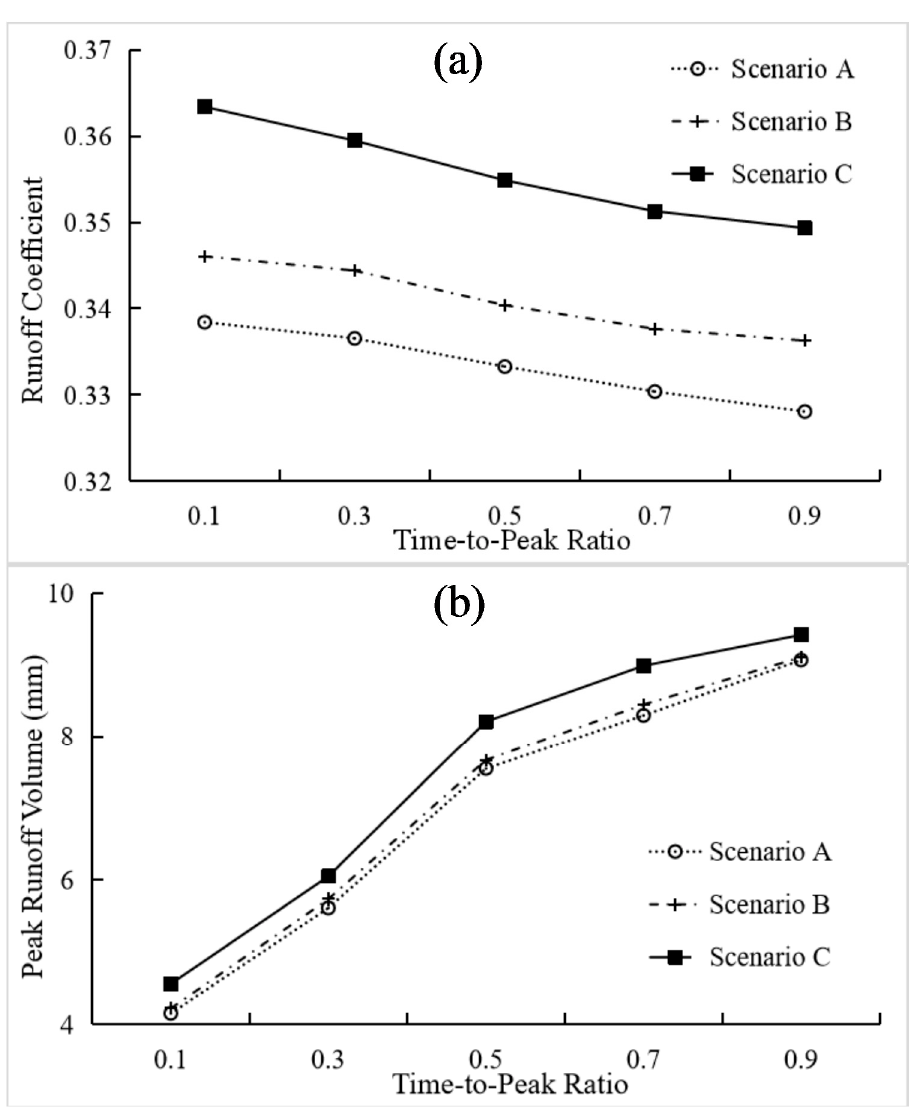
Figure 7. The runoff coefficients ( a ) and peak runoff volumes ( b ) simulated in SWMM under the storms in Group III.